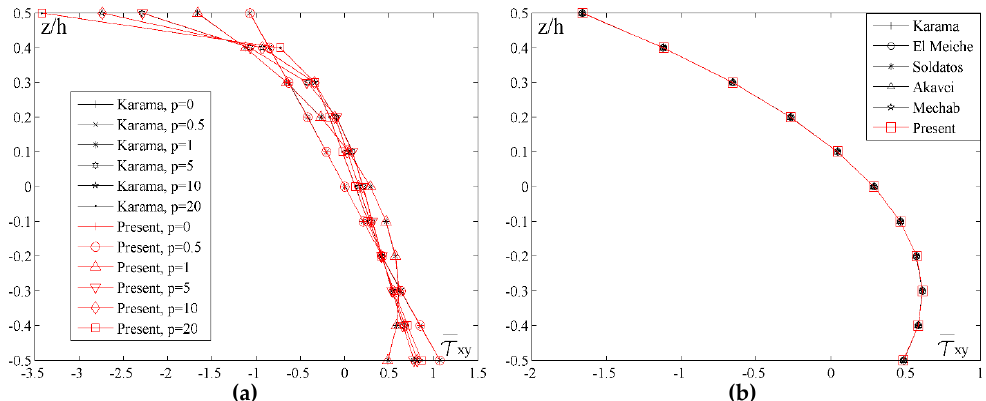
Figure 7. Distribution of the normalized values of the shear stress τ xy across the thickness of the plate for different values of the index p and different shape function: ( a ) a / h = 10, a / b = 1; ( b ) a / h = 10, a / b = 1, p = 5.